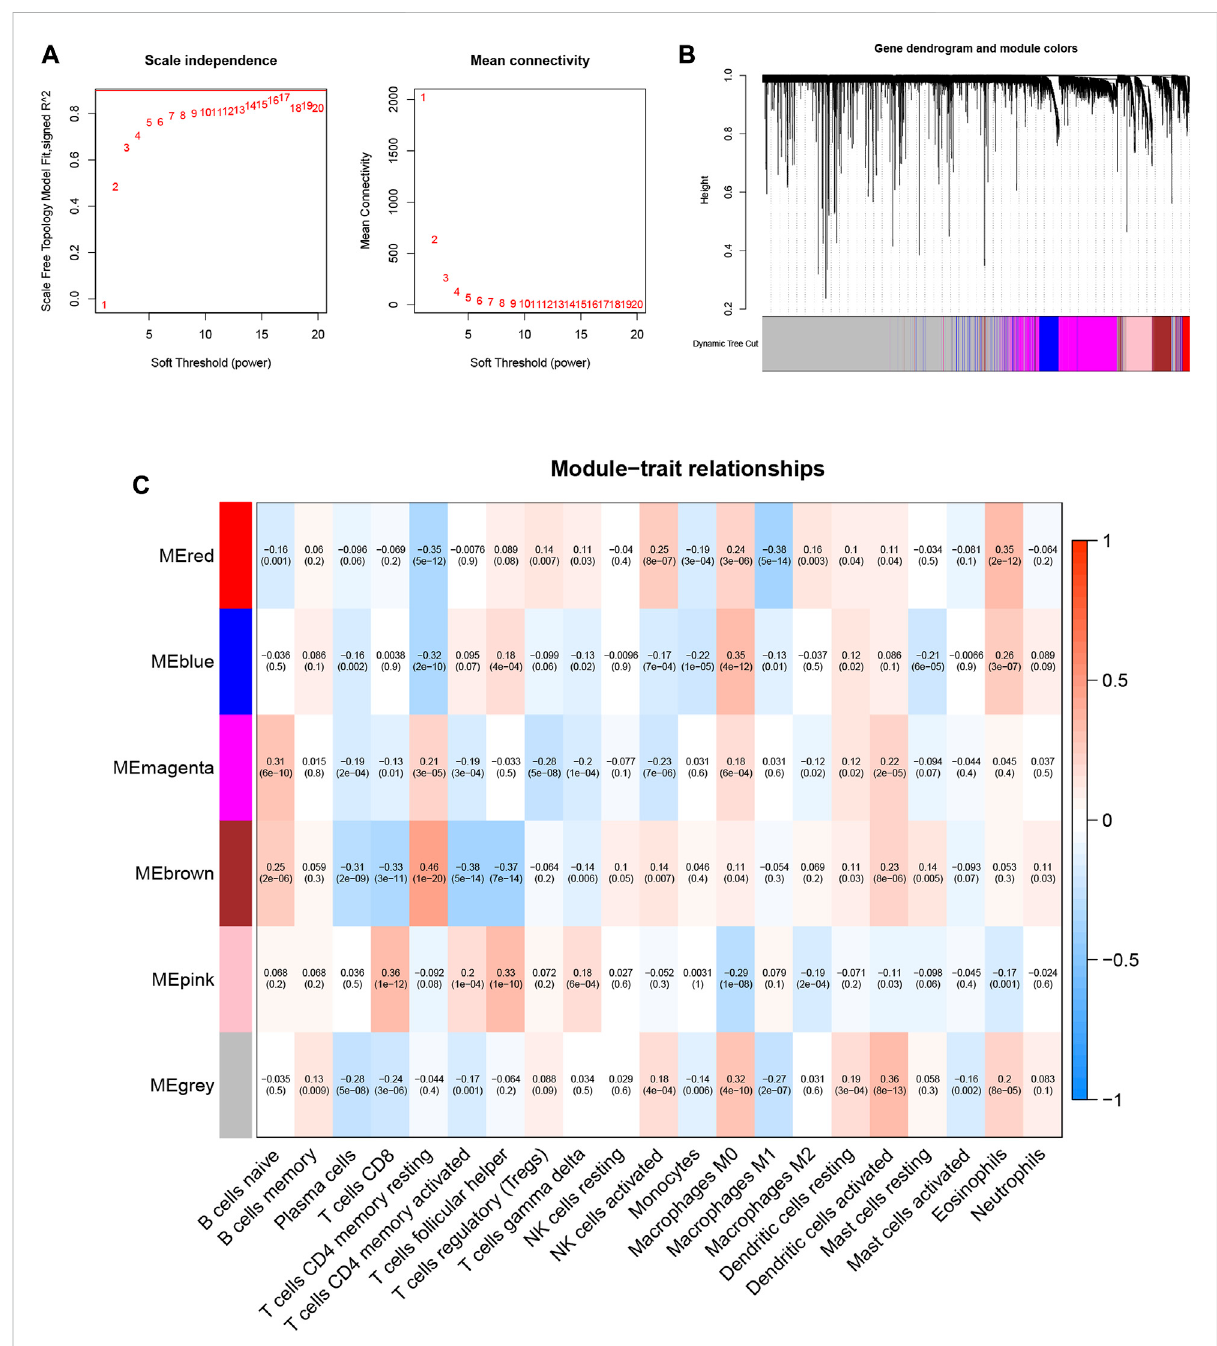
FIGURE 2 Choosing an appropriate soft threshold (power) and building a hierarchical clustering tree. (A) The choice of the soft threshold enables the scale-free topology to achieve an exponentof 0.90, and theaverage connectivity for 1 – 20 softthresholdpowers isanalyzed. (B) Neutrophil-related geneswith similarexpression patterns weremergedinto thesamemoduleusing adynamictree-cutting algorithm, creatingahierarchicalclustering tree. Heatmap of correlations between (C) modules and immune-in fi ltrating cells